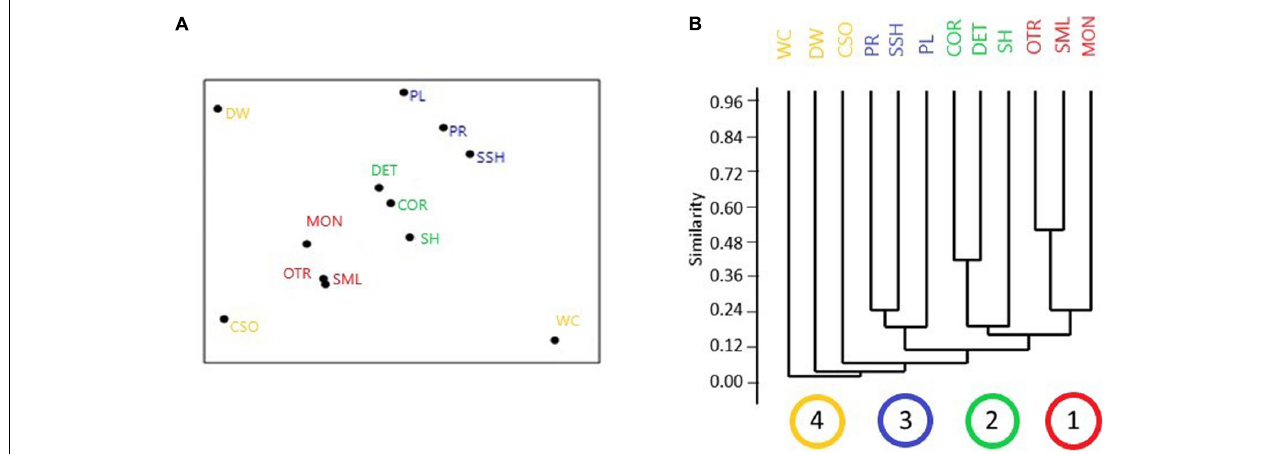
FIGURE 4 | Graphical results of non-metric multidimensional scaling (nMDS) (A) and cluster (B) analysis for the comparison between bryozoan assemblages of the mesophotic sites and those of other benthic habitats. Mesophotic sites: MON, Monopoli; OTR, Otranto; SML, Santa Maria di Leuca. Other benthic habitats considered: COR, coralligenous; CSO, semi-dark submarine caves; DET, detritic bottoms; DW, outer shelf–upper slope deep habitats; PL, Posidonia meadow leaves level; PR, Posidonia meadow rhyzomes level; SH, shelf sciaphilic habitats; SSH, shallow shelf photophilic habitats; WC, white coral banks. In the abscissa axis of panel (B) , the four main clusters are shown: brown = the mesophotic investigated sites (MON, OTR, SML); green = the circalittoral and sciaphilic habitats (DET, COR, SH); blue = the shallowest and photophilic habitats (PL, PR, SSH); yellow = other habitats (CSO, DW, WC) (nMDS stress